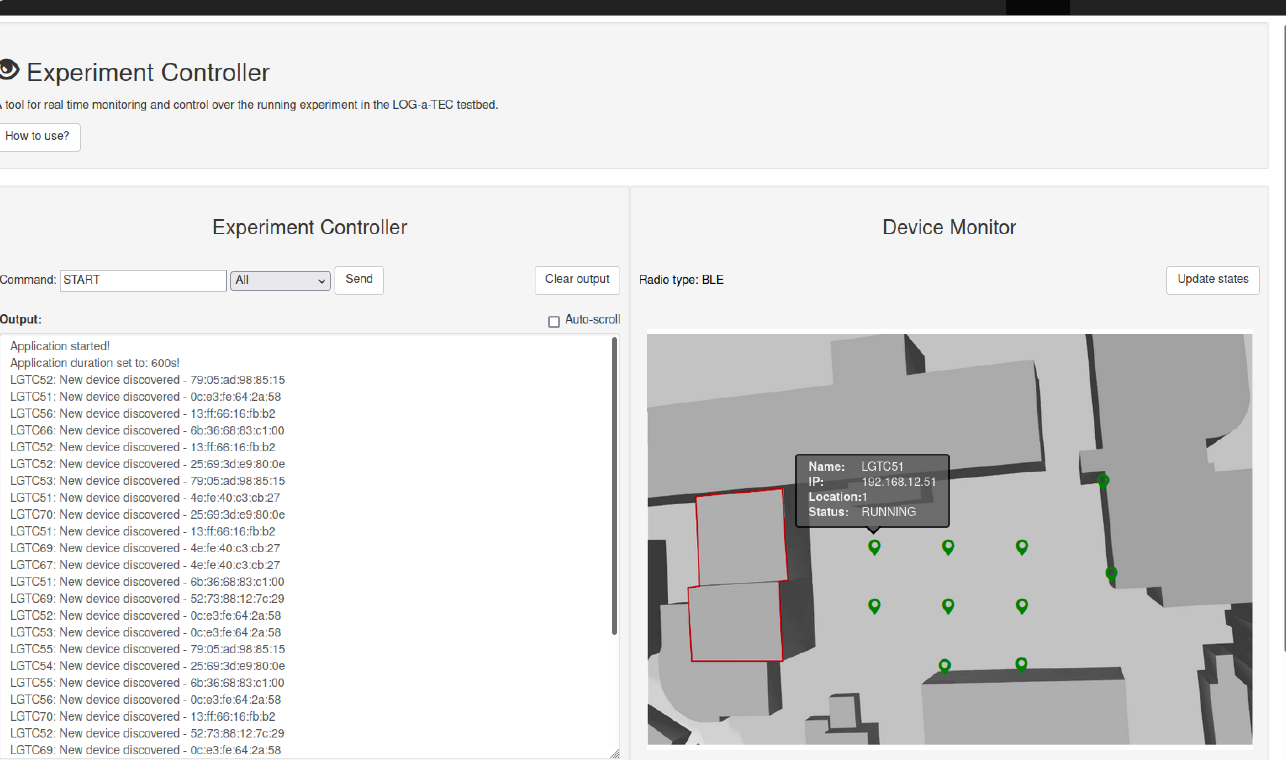
Figure 3. EC and MS graphical user interface during experiment